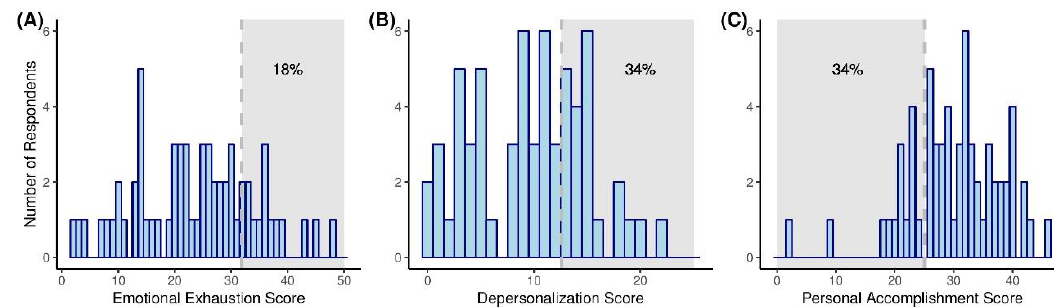
Figure 1. Maslach Burnout Inventory—Human Services Survey subscale scores. Histograms depicting score frequency by subdomains of ( A ) Emotional Exhaustion, ( B ) Depersonalization, and ( C ) Personal Accomplishment. The number of percentage in the shaded region indicates the proportion of the highest tertile in each domain. Overall burnout was considered present when any two or all domains met the criteria (Emotional Exhaustion ≥ 32, Depersonalization ≥ 13, or Personal Accomplishment ≤ 25). Based on OSI-R normative data, 57% ( n = 35), 5% ( n = 3), 26% ( n = 16), 27% ( n = 17), 36% ( n =